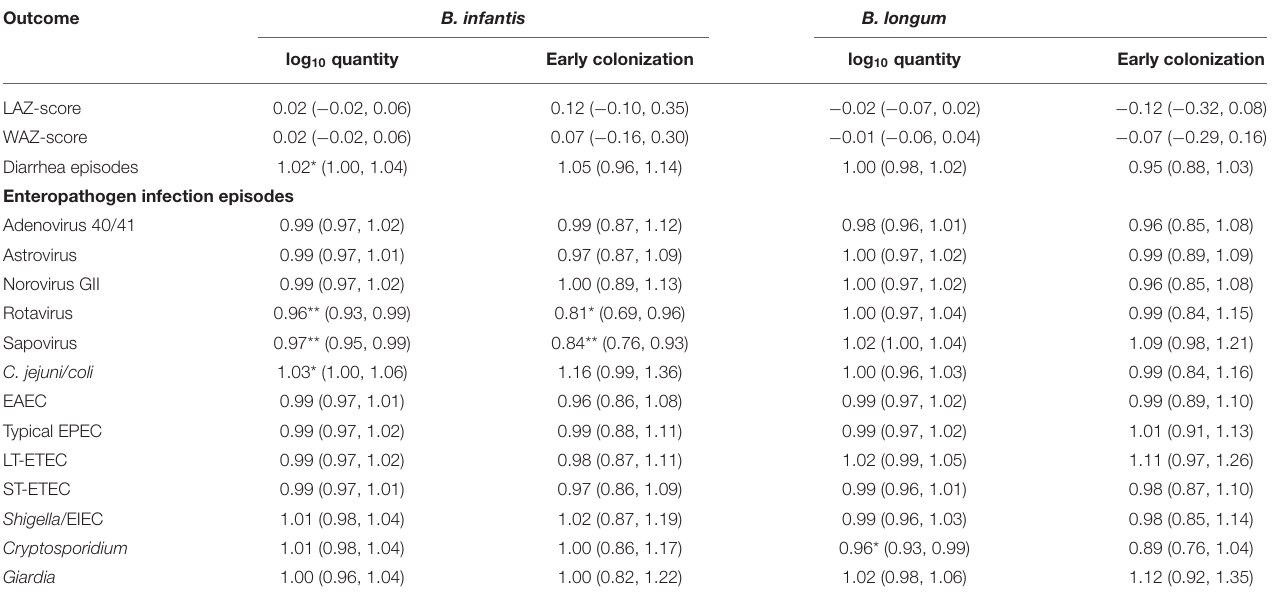
TABLE 4 | Coefficient estimates and risk ratios (with 95% confidence intervals) from longitudinal models of the associations between indicators of quantity and early colonization for two Bifidobacterium longum subspecies and time-varying anthropometric and enteric infection outcomes from ages 1–24 months adjusted for site, age, feeding status, WAZ-score at enrollment, socio-economic status (WAMI score) and sex.